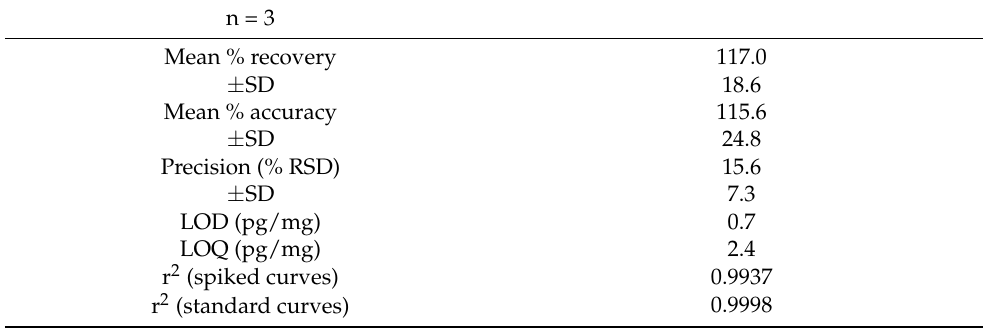
Table 2. Validation parameters of the applied methodology.